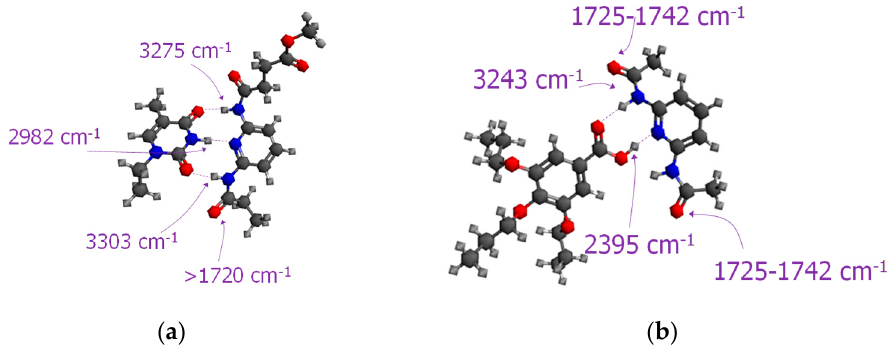
Figure 6. Formation of ( a ) DAP ● tAZOi-3HB and ( b ) DAP ● dAZOi-2HB hetero-complexes, via molecular recognition. Vibration frequencies calculated by DFT are also shown (see Table S4 in Supplementary Materials). Table 1. Dissociation energies, ∆ E dis /kJ mol − 1 , of the supramolecular dimers and trimers (modelling the pristine compounds) and complexes (modelling the mixtures) obtained by DFT.